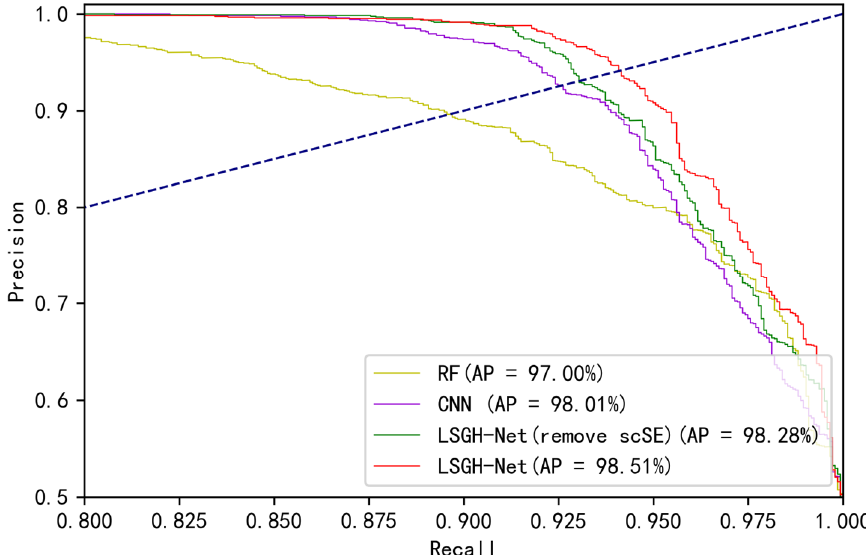
Figure 8. Comparison of multi-model PR curves and AP values.